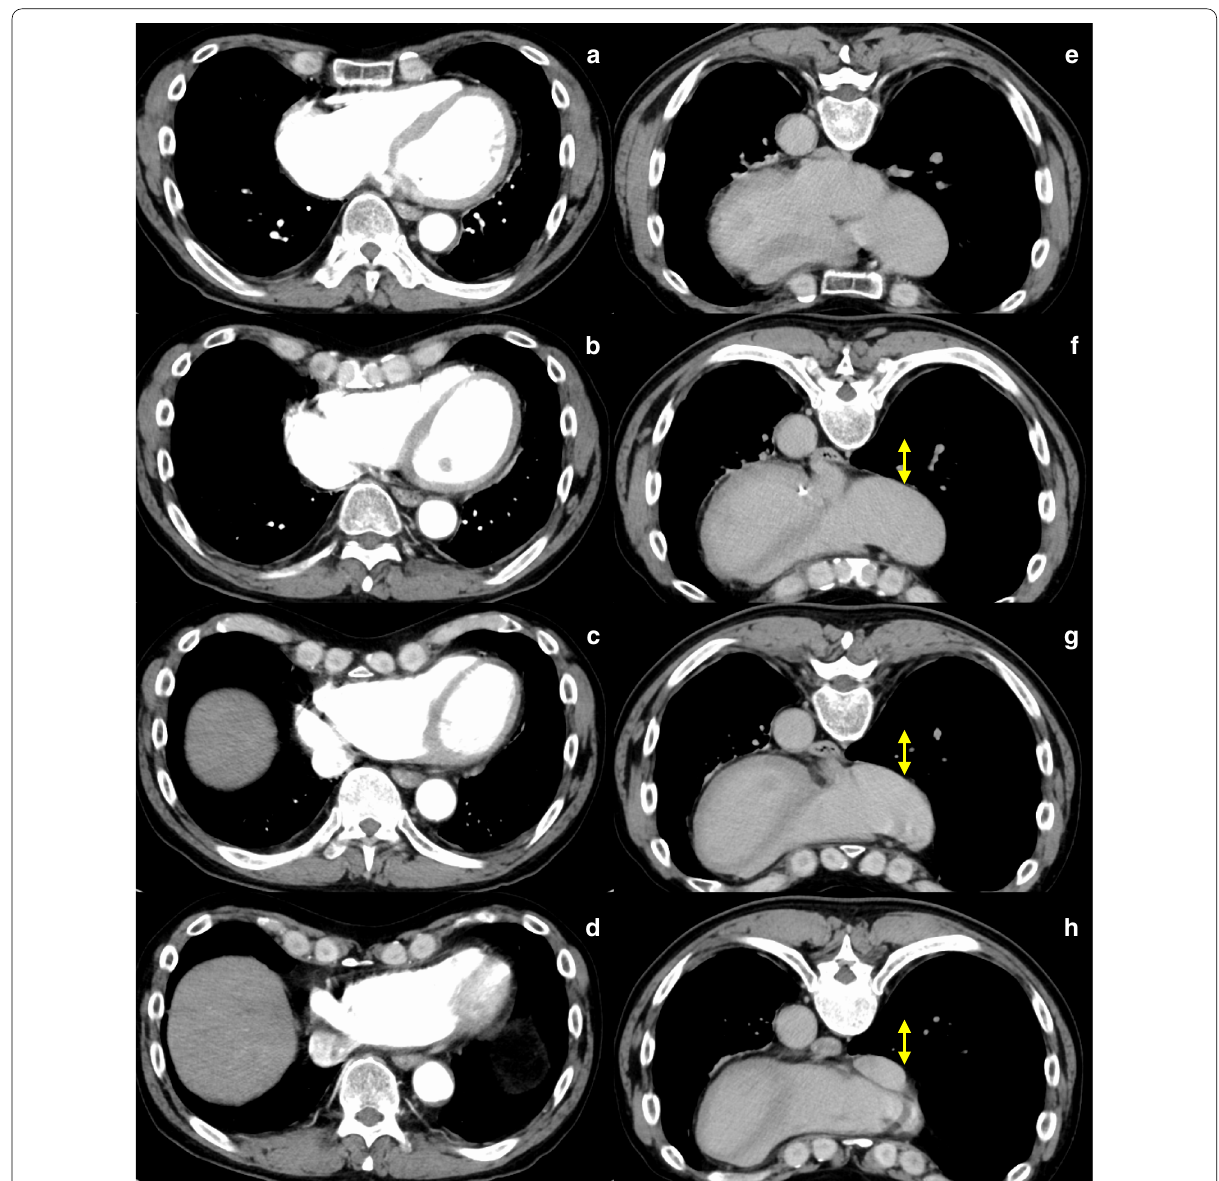
Fig. 4 Patient 2. a – d Contrast-enhanced CT in the supine position showing the pectus excavatum. The Haller index score was 4.3. e – h CT image in the prone position revealed dilated mediastinum (arrow) compared to a – d . CT slice level was matched based on the sternal